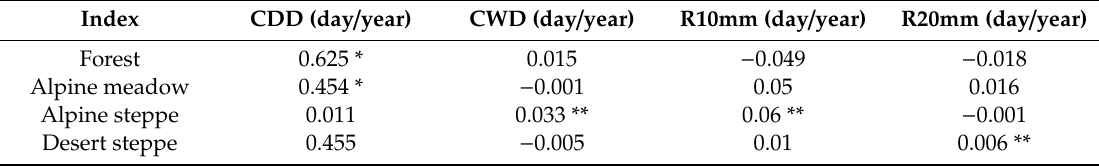
Figure 6. Temporal pattern of precipitation days in different ecosystems of the Tibetan Plateau from 1986 to 2015. Graphs represent ( a ) annual variation of CDD in different ecosystems, ( b ) CWD, ( c ) R10mm, and ( d ) R20mm. Table 5. Precipitation days linear trend and significance in different ecosystem.